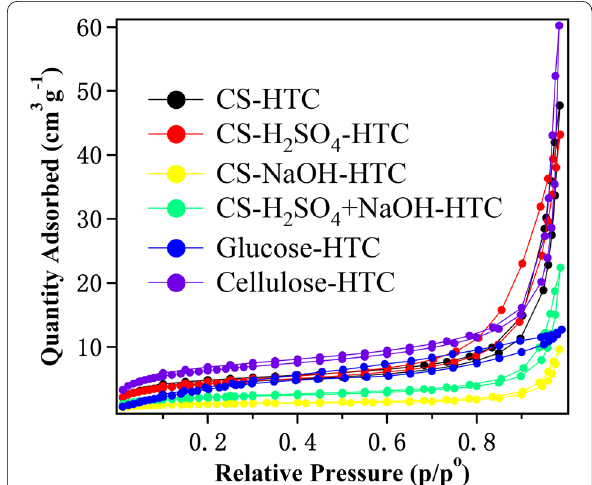
Fig. 3 N 2 adsorption–desorption isotherms of prepared